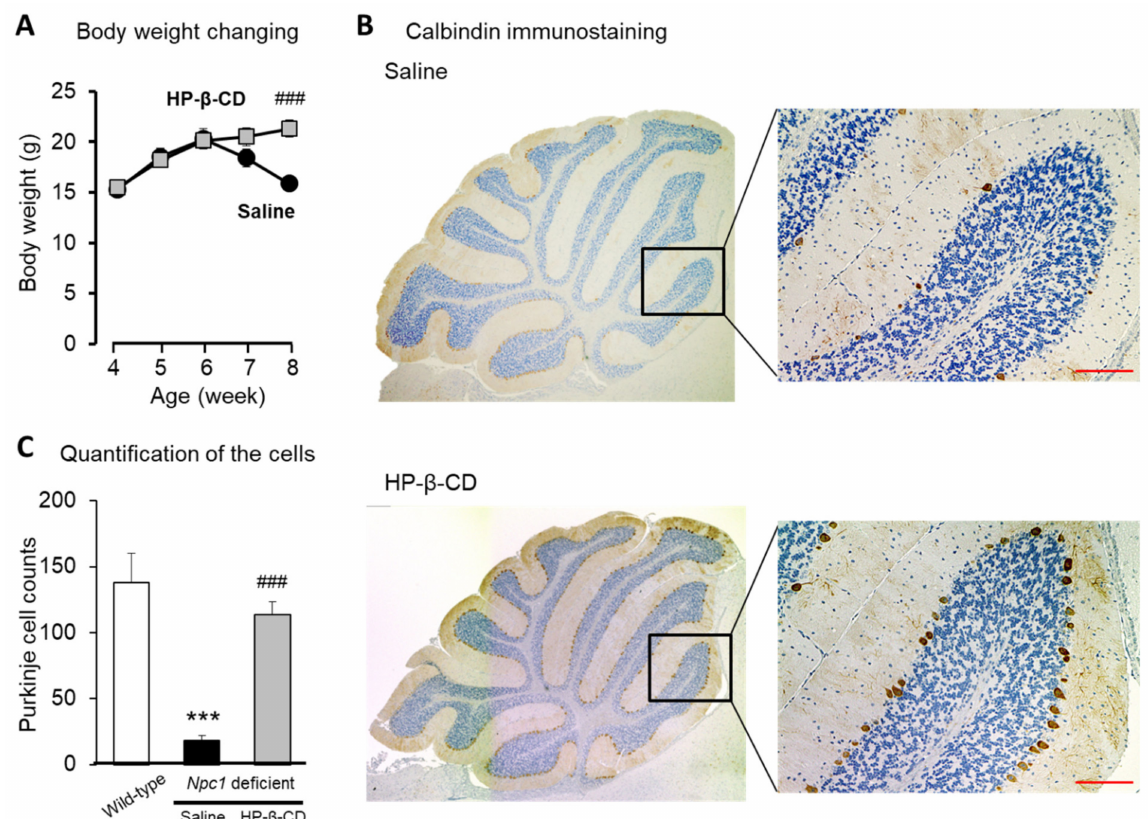
Figure 1. Potential of the intracerebroventricular administration of 2-hydroxypropyl- β -cyclodextrin (HP- β -CD) to protect against reductions in body weight ( A ) and cerebellar Purkinje cells (B and C) in Npc1 − / − mice. HP- β -CD was administered at 21.4 µ mol/kg in mice at 4 and 6 weeks of age. We recorded the changes in body weight once a week from 4 to 8 weeks old. We collected samples from the whole brain, liver, and blood at 8 weeks and 3 days of age and analyzed them. Histological images of the mouse cerebellum ( B ). Scale bar: 100 µ m. Quantitative evaluation of calbindin-positive cells ( C ). Data are presented as the mean ± S.E. ( n = 8–11). *** p < 0.001 compared with the wild-type group. ### p < 0.001 compared with the saline